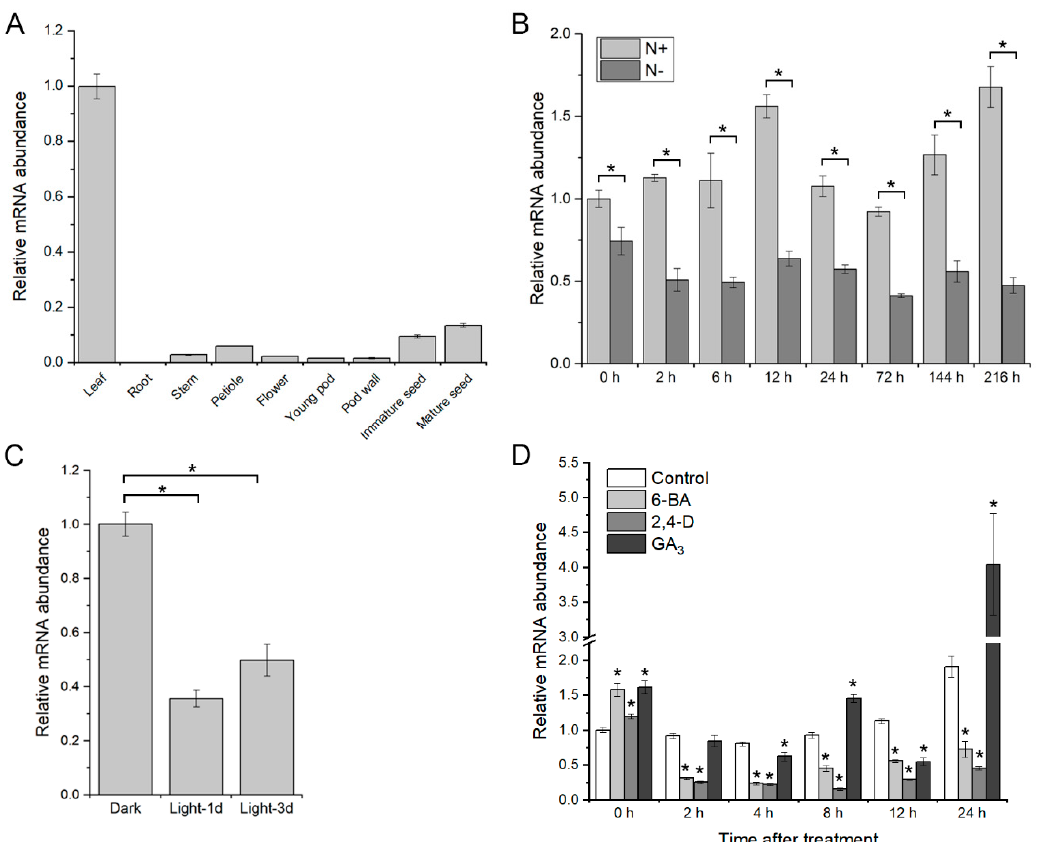
Figure 2. Expression pattern of GmGATA58 in various tissues of soybean ( A ) and in response to nitrogen ( B ), light / dark ( C ) and three phytohormones treatments ( D ). A, it is noted that pod wall sample are collected from immature pod. B, soybean seedlings were grown in the 7.5 mM solution of normal nitrogen (N + ) or the 0.75 mM solution of low nitrogen (N − ) conditions for up to 9 days. C, soybean seedlings were grown in continuous dark condition for 3 days and then transferred to continuous light condition for up to 3 days. D, the 15-day-old seedlings were sprayed with 100 µ M 6-BA, 100 µ M 2, 4-D or 100 µ M GA 3 phytohormones and distilled water as the control. The leaves of seedlings treated with nitrogen, light and phytohormones were harvested for qPCR assay at the di ff erent times. The GmACT11 gene was used as a reference gene and column values represented mean ± SD (standard deviation). Asterisks (*) represent significant di ff erence between groups or against the control in hormones treatment at the level of p <